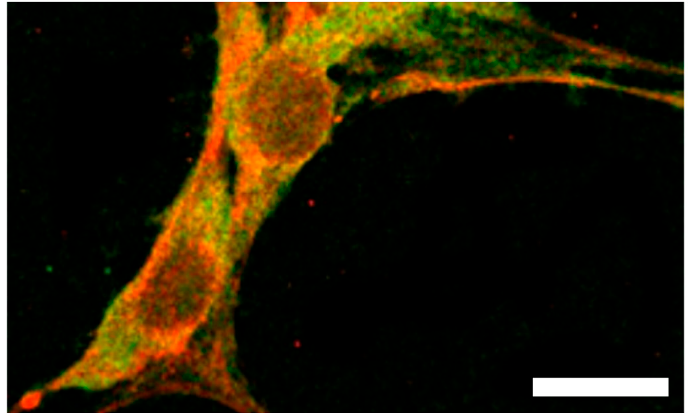
Figure 5. Double-fluorescence immunocytochemical image of neuronal progenitor cells on day 14 of culture, obtained using a laser scanning confocal microscope. Von Hippel-Lindau (VHL) protein and microtubule-associated proteins (MAPs) are co-expressed in neuronal progenitor cells. VHL is detected with fluorescein isothiocyanate (FITC, green), and MAPs are detected with rhodamine (red). Scale bar = 10 μ m.